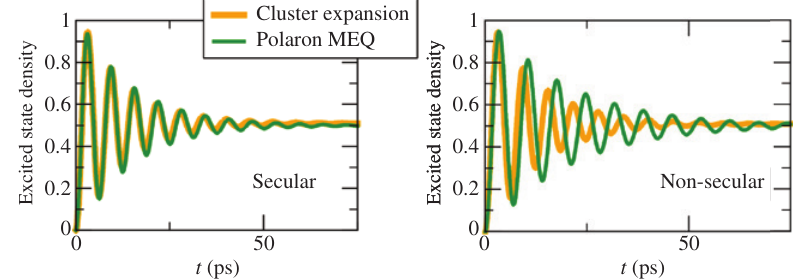
Figure 7: Comparison between the polaron master equation and cluster expansion solution in the second-order and weak driving limit ( ħ Ω = 50 μ eV). The solutions agree well without nonsecular terms and Rabi energy renormalization (left) for temperatures up to T = 77